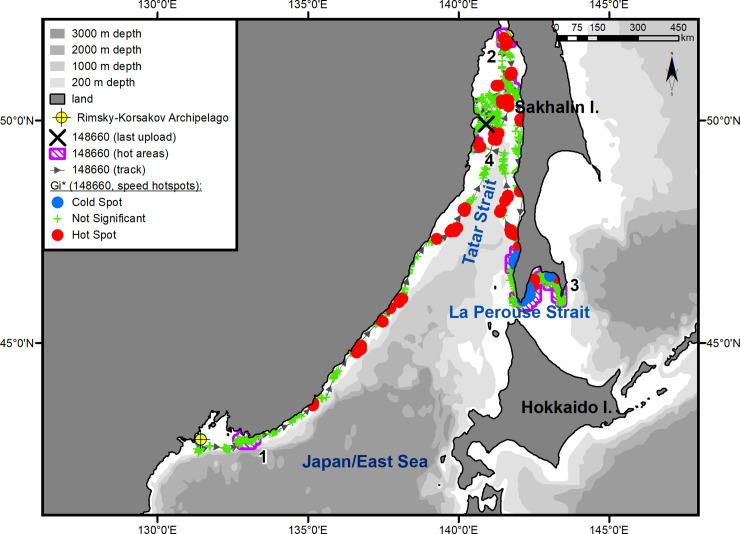
Summer–autumn migrations of yearling male #148660.